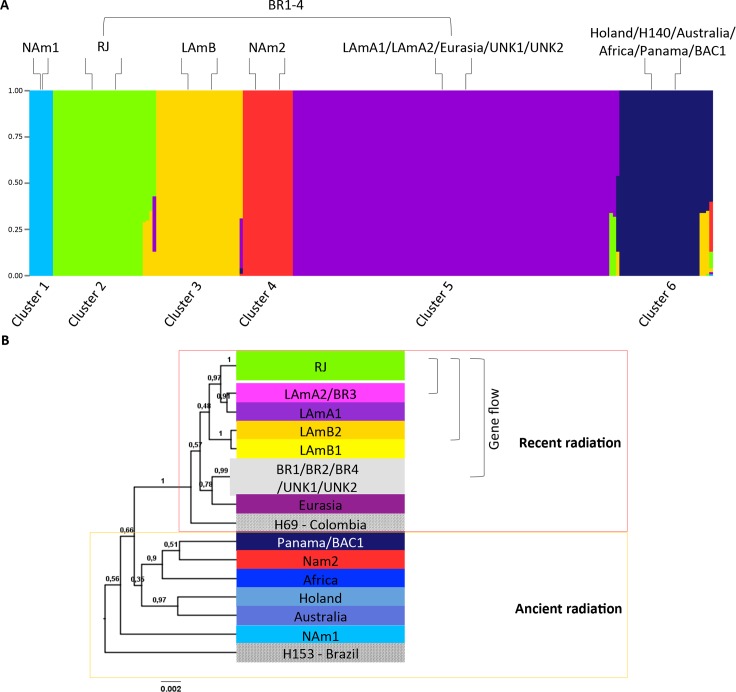
Population structure of Histoplasma capsulatum deduced by Bayesian Analysis of Population Structure (BAPS).A) Structure plots of 205 isolates revealing 6 different major populations (Clusters 1–6). Phylogenetic species were assigned to each of the six deduced populations as follows: Cluster 1 representing the phylogenetic species NAm 1, Cluster 2 representing the phylogenetic species RJ, Cluster 3 containing LAm B, Cluster 4 constituted by phylogenetic species NAm 2, Cluster 5 constituted by LAm A1, LAm A2, BR1-4, and the paraphyletic low supported clades Eurasia, Unknown 1 and Unknown 2 and Cluster 6 containing Netherlands, Panama, Africa, Australia and BAC1. B) Bayesian population tree based on substructures of the 6 initial clusters deduced by BAPS. Gene flow is represented by mixture isolates that are annotated with brackets along the tree.